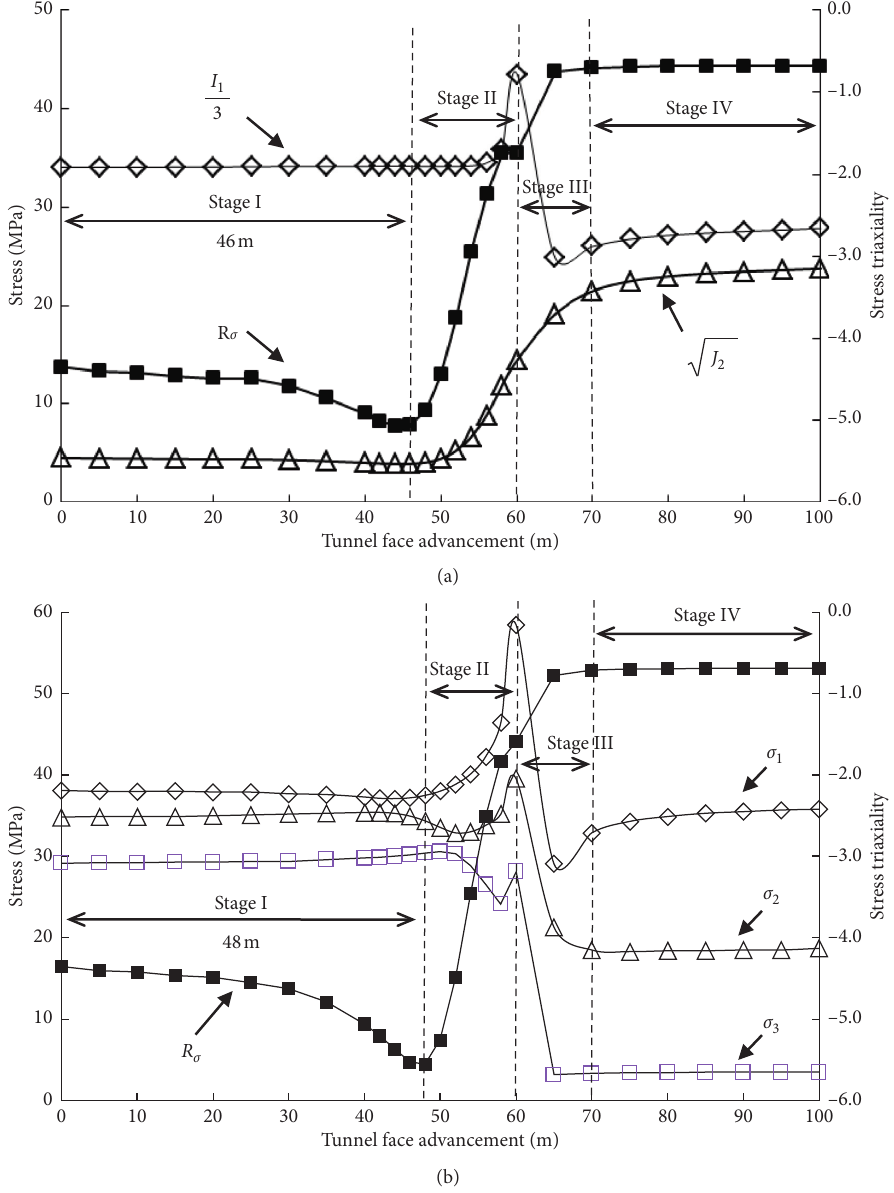
�� 􏽰 J , σ , σ , I /3, with tunnel face advancing (Stage I: stress adjustment; Stage II: principal stress axis , and R 1 2 3 1 2 σ